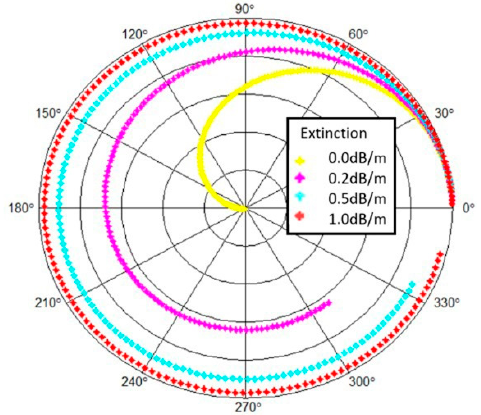
Figure 8. The volume coherence loci representation in the complex unit circle [7].